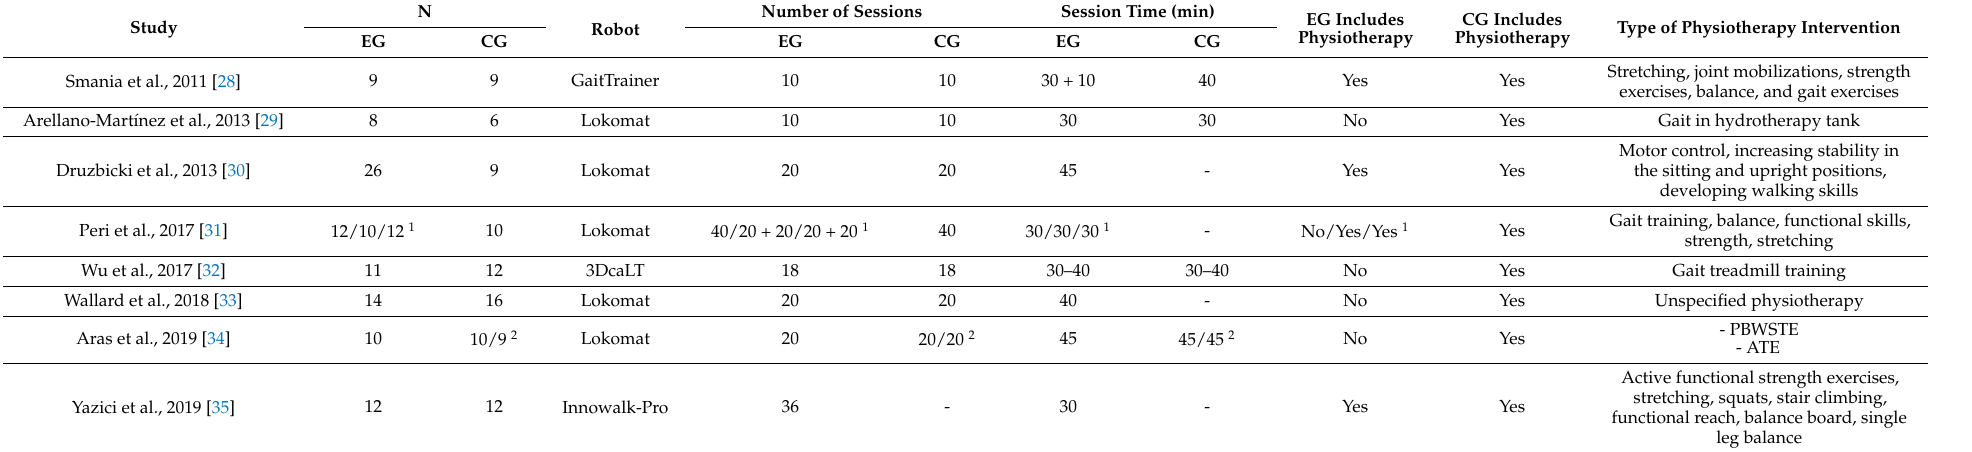
Table 2. Characteristics of treatments for included